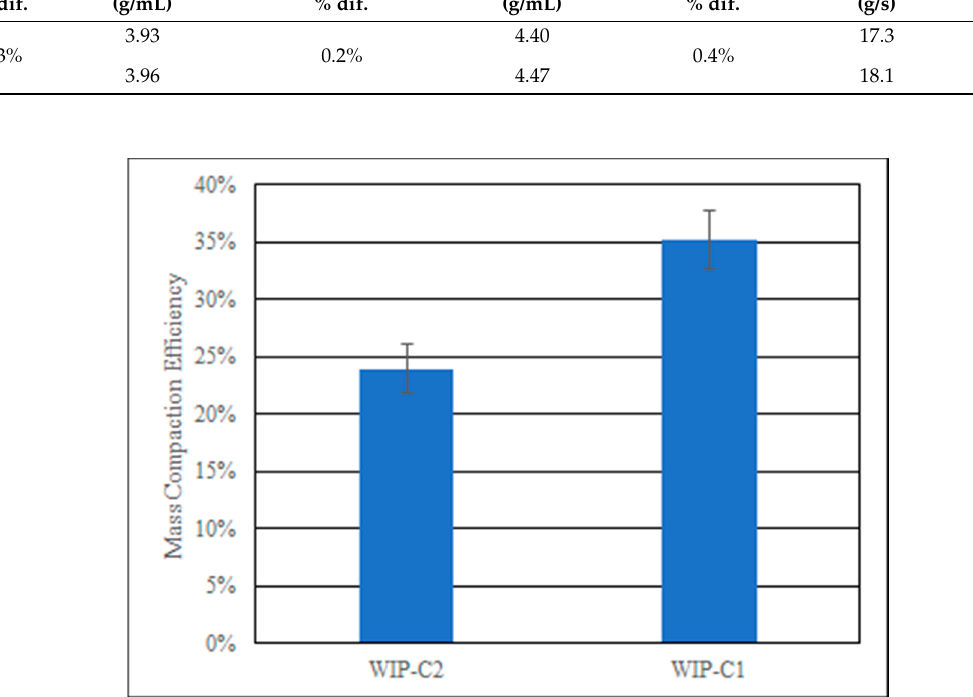
Figure 13. Percent mass compacted values for WIP-C1 and WIP-C2.